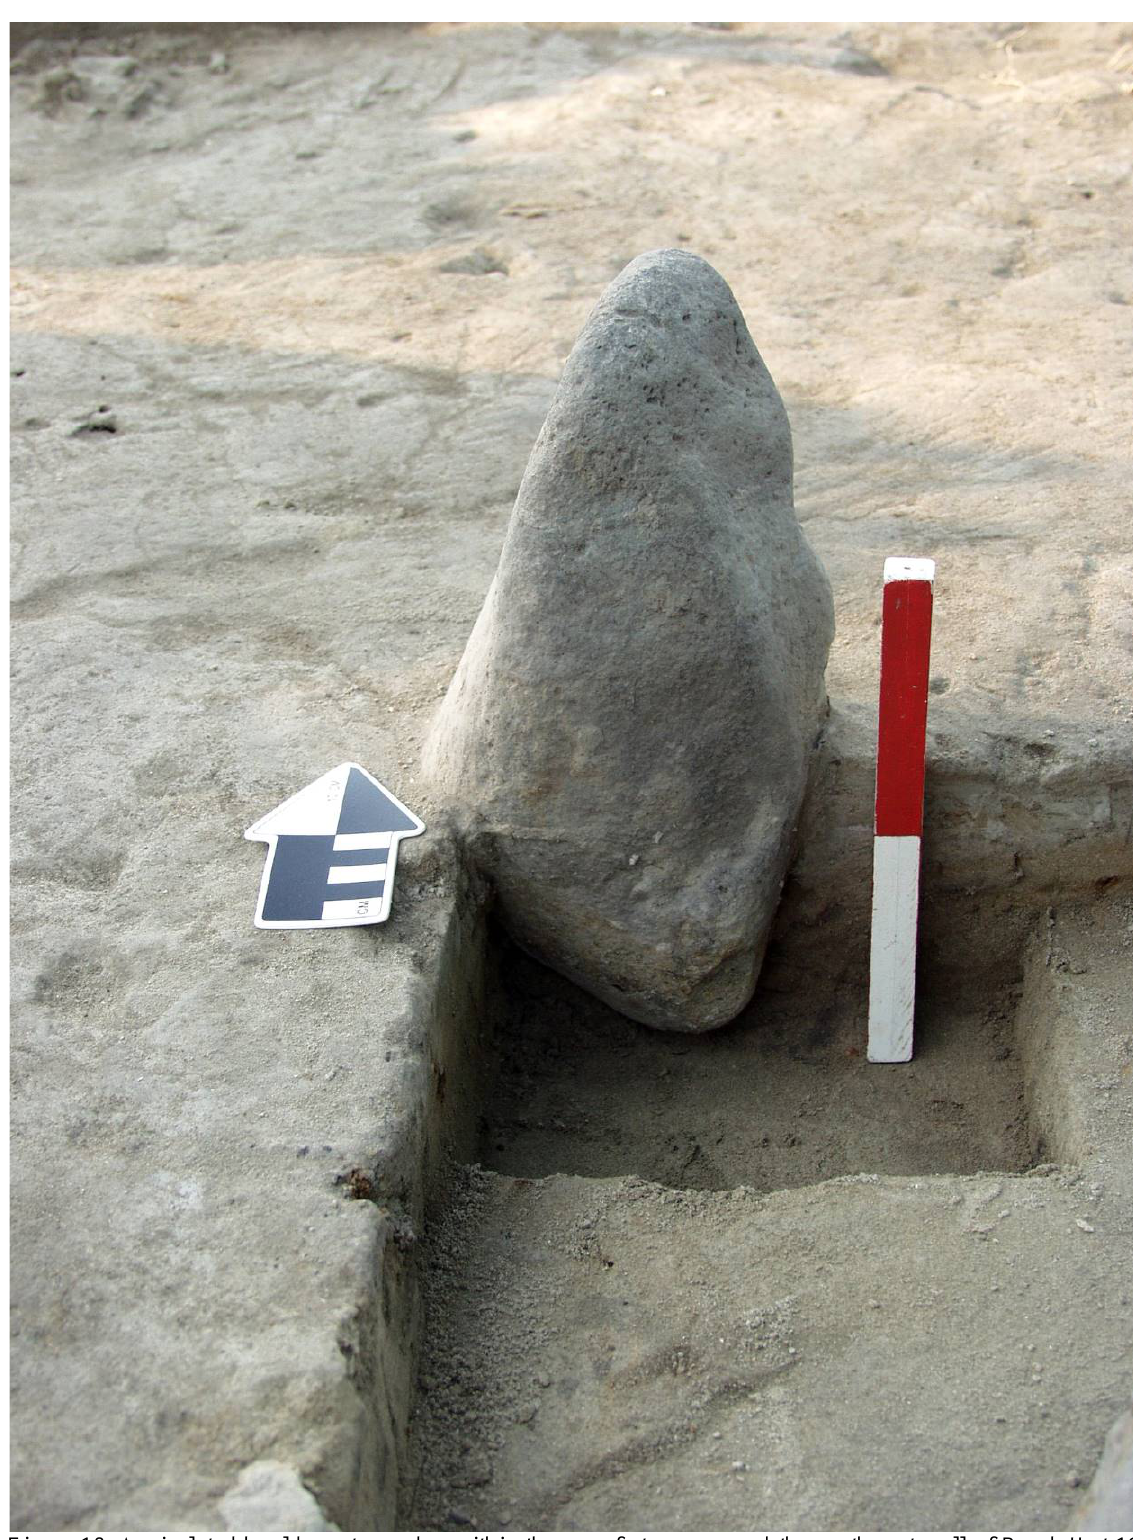
Figure 18. An isolated boulder set on edge within the arc of stones around the northwest wall of Brush Hut 12 (Figure 17). Vertical scale bar 20